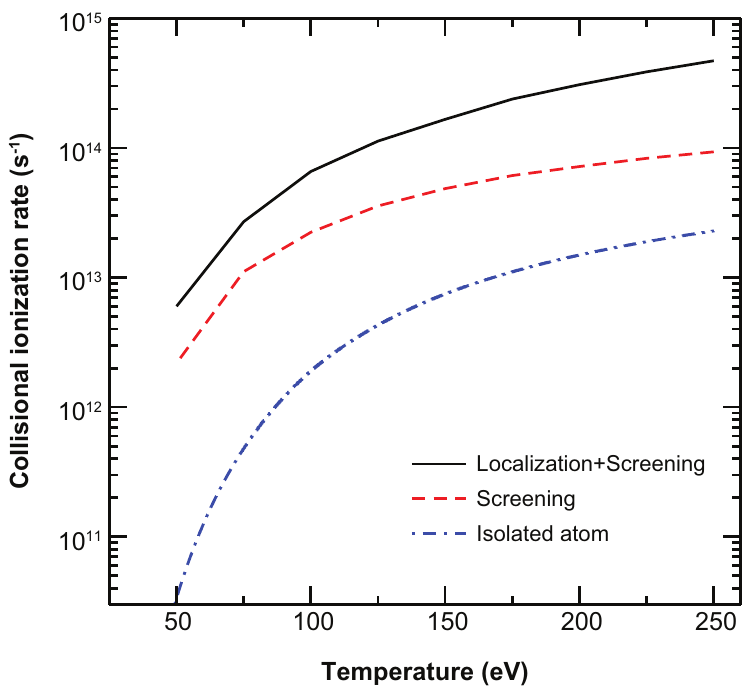
Figure 4. Electron–ion collisional ionization rates. The rates are given as a function of plasma temperature for solid-density magnesium